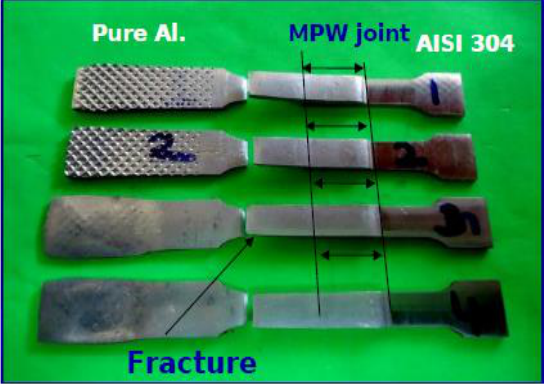
Figure 8. Lap-shear tests showing failure outside the welded zone.